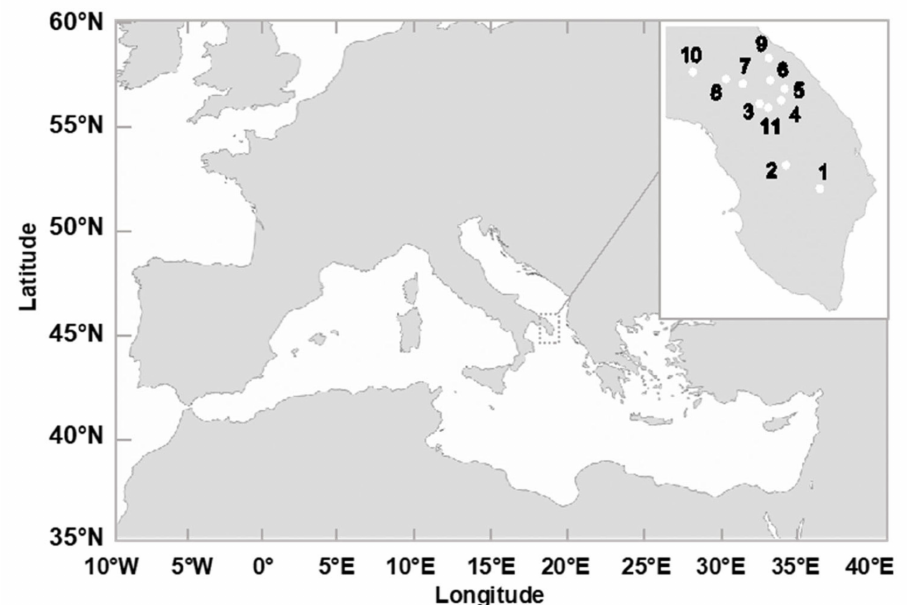
Figure 1. The map illustrates the geographical location of the study area in south-eastern Italy, in the Central Mediterranean basin. The location of the monitoring stations of the Apulia Region Air Quality Agency (ARPA Puglia) considered in this study (Maglie 1, Galatina 2, Arnesano 3, Lecce—Libertini 4, Lecce—Garigliano 5, Surbo 6, Campi Salentina 7, Guagnano 8, Cerrate 9, and San Pancrazio 10) is also reported in the insert, in addition to the AERONET photometer site at the Department of Mathematics and Physics of the University of Salento in Lecce